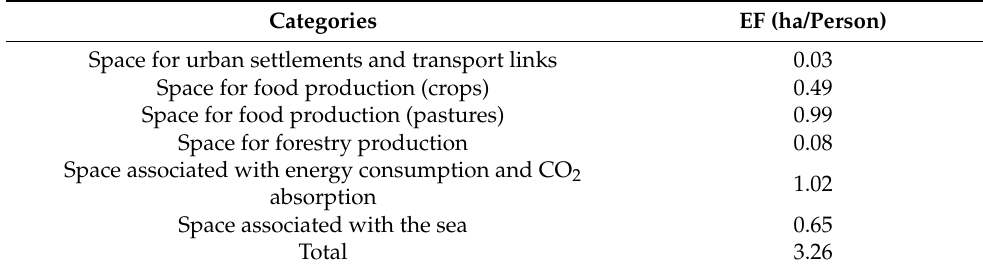
Table 9. Ecological footprint of Catalonia per capita in 1996.Source: Relea and Prat, 1996. Categories EF (ha/Person) Space for urban settlements and transport links 0.03 Space for food production (crops) 0.49 Space for food production (pastures) 0.99 Space for forestry production 0.08 Space associated with energy consumption and CO 2 1.02 absorption Space associated with the sea 0.65 Total 3.26